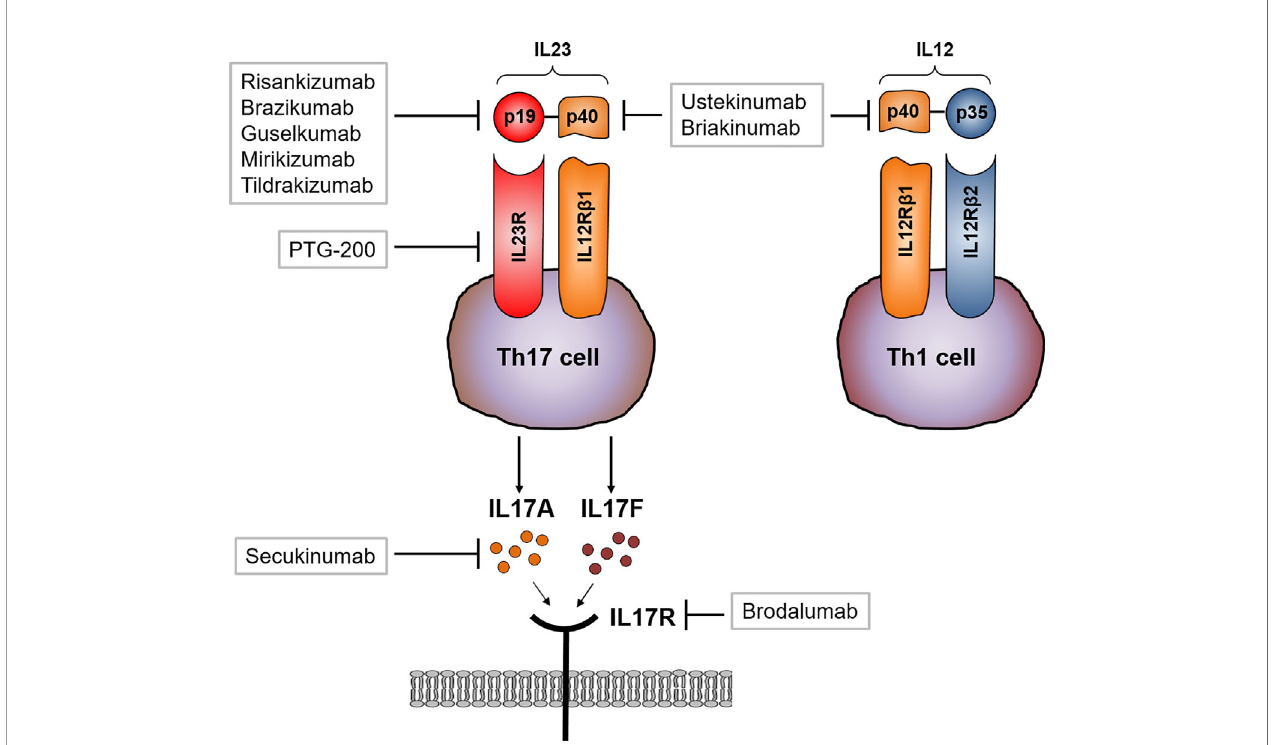
FIGURE 4 | Therapeutic approaches targeting IL23 and IL17 signaling. Ustekinumab and briakinumab speci fi cally blocks the IL12/IL23 subunit p40 in CD patients whereas risankizumab, brazikumab, guselkumab and mirikizumab selectively block the unique subunit p19. Activated Th17 cells produce large amounts of IL17. Secukinumab directly binds to IL17A and thereby inhibits the interaction with the IL17 receptor (IL17R). Brodalumab directly binds to the IL17R causing an inhibition of IL17 ligand binding (A and F) to their